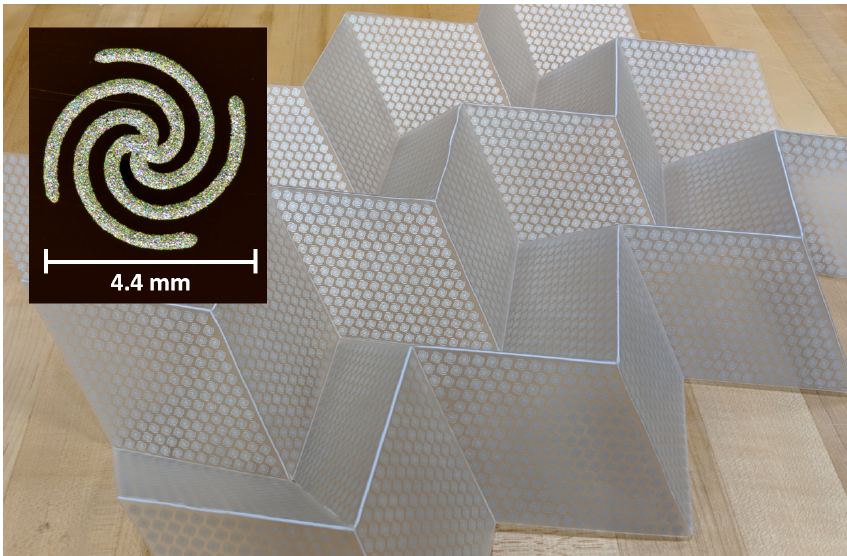
Figure 7. Fabricated specimen Miura-ori FSS. Triangular lattice of silver thermoplastic polyurethane (Ag-TPU) spirals printed on a laser-cut PP substrate folded according to the Miura-ori pattern. Inset: Representative optical image of the printed Ag-TPU